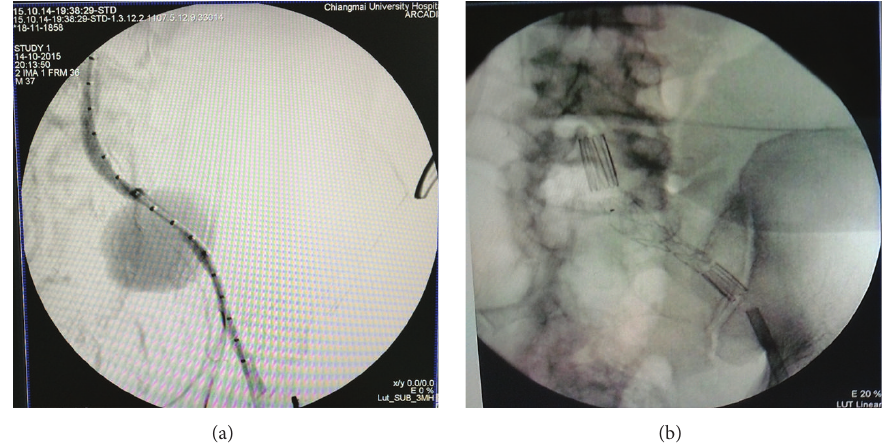
Figure 2: Intraoperative angiography. (a) showed angiogram with large concealed rupture in the left common iliac artery aneurysm in the second case. (b) showed angiogram after left iliac stent covered leakage